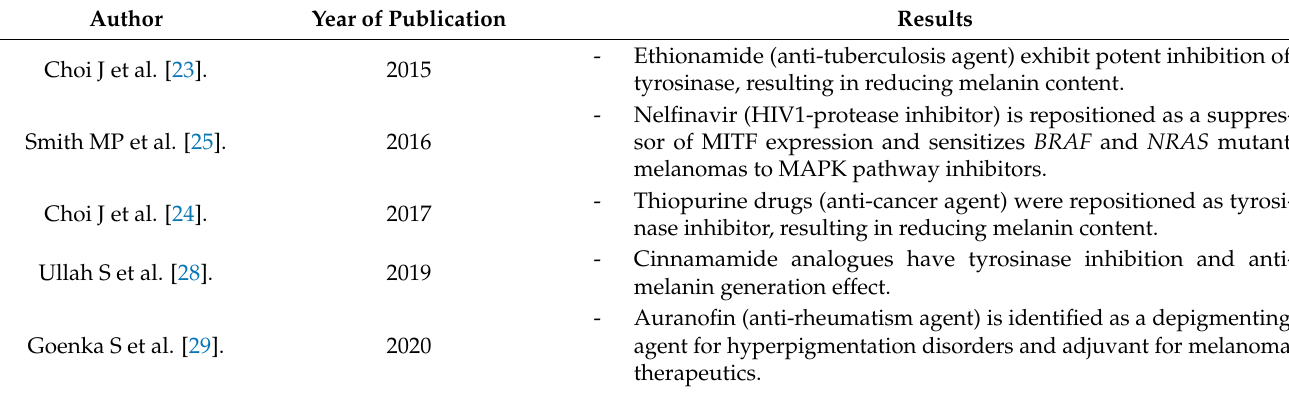
Table 2. An overview of previous studies on the regulation of melanogenesis by drug repositioning.